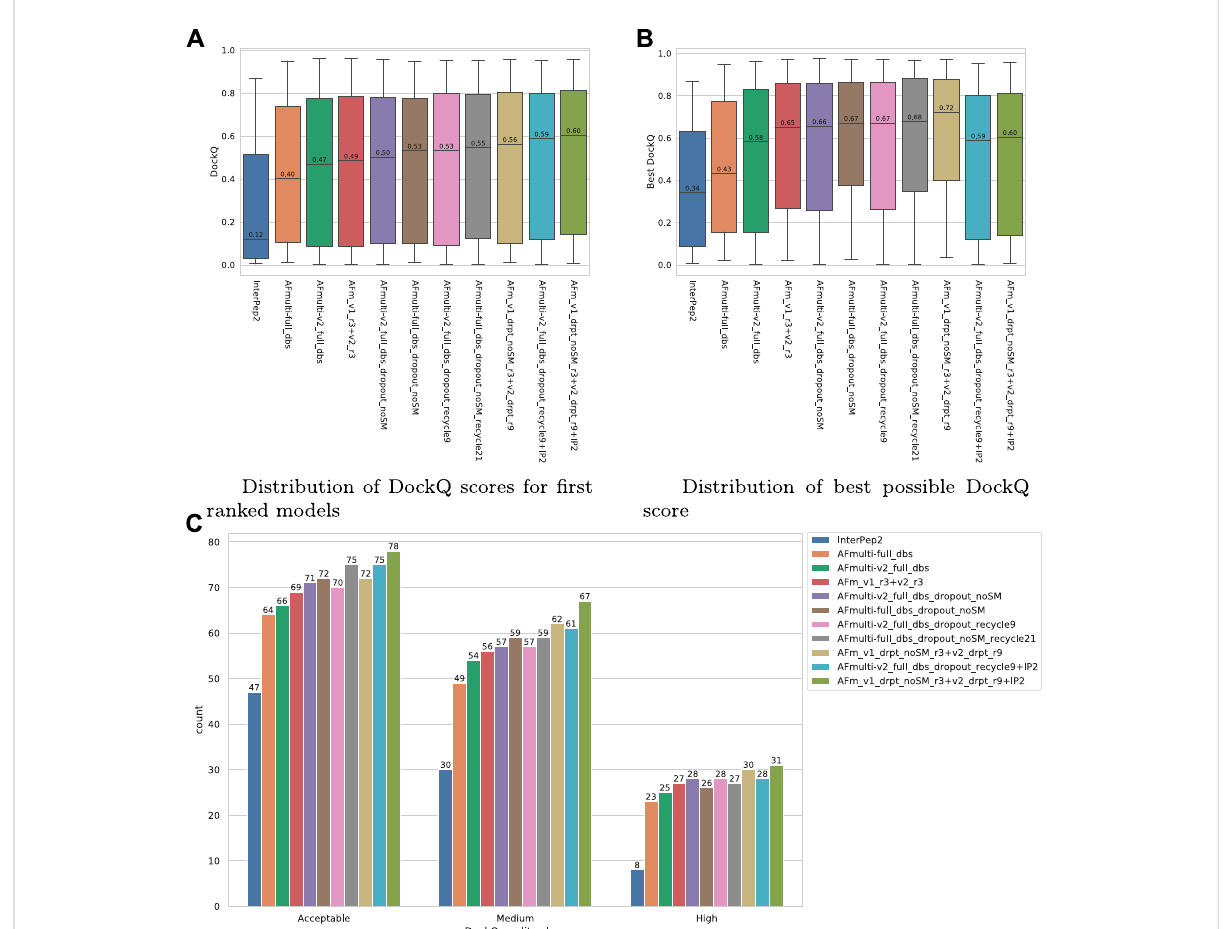
FIGURE 7 PerformanceofdifferentAlphaFold-Multimer versions;InterPep2isincludedas areference to thepreviousmethods. (A) Distribution ofDockQ scores for fi rst ranked models. (B) Distribution of best possible DockQ score. (C) Distribution of how many of the total 112 targets have fi rst-ranked models with acceptable, medium, and high quality,